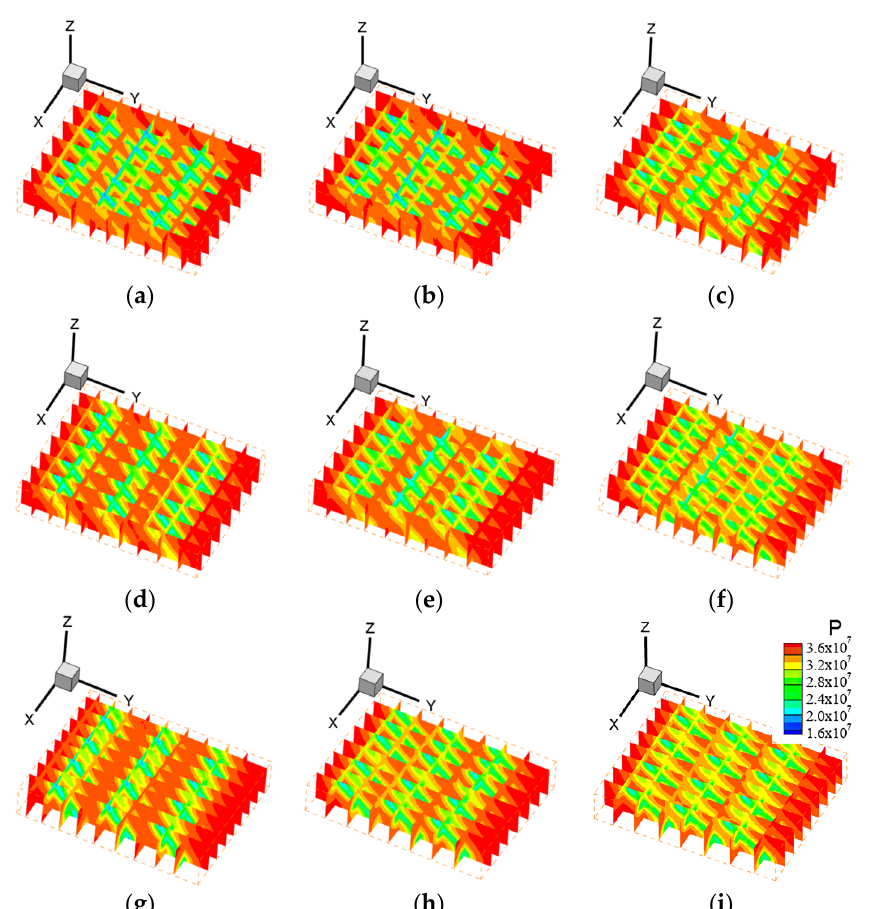
Figure 13. Deviated well pressure distribution field diagram after different development schemes.